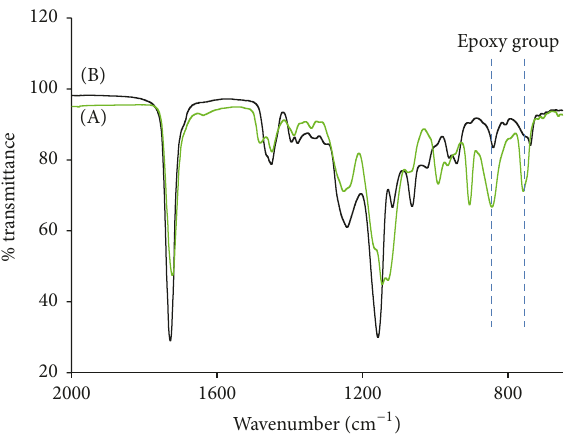
Figure 2: FTIR spectra of poly(GMA- co -nBA) microspheres (A) and poly(GMA- co -nBA) microspheres (B) after conjugation. FTIR spectra showed the decreasing peak intensity of epoxy group before and after polymer